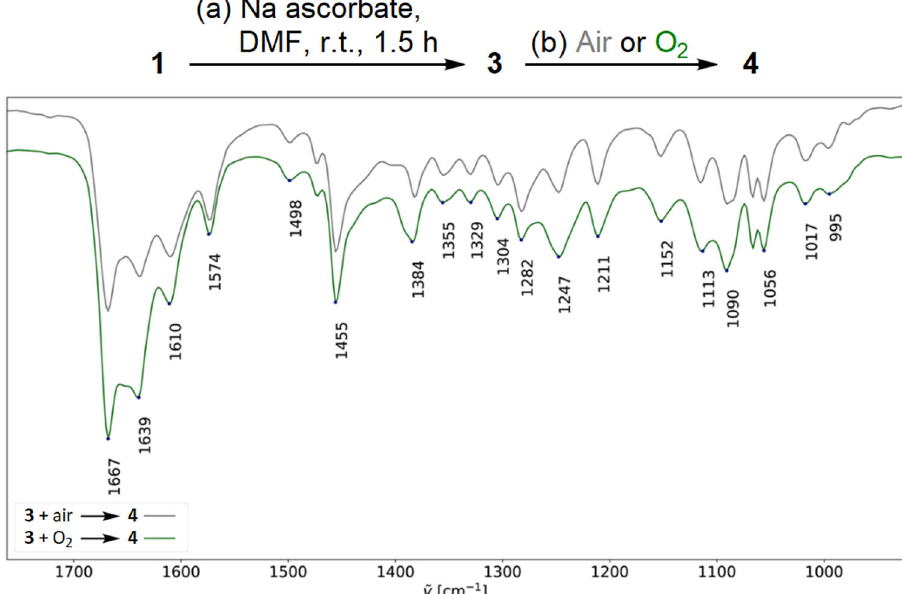
Fig. 2 Formation of the oxalate complex 4 from 3 requires O 2 and does not require CO 2 . FTIR spectra for the products obtained when 3 (prepared in situ from 1 and ascorbate) was exposed to air (grey) or pure O 2 (green) are identical (details are given in the